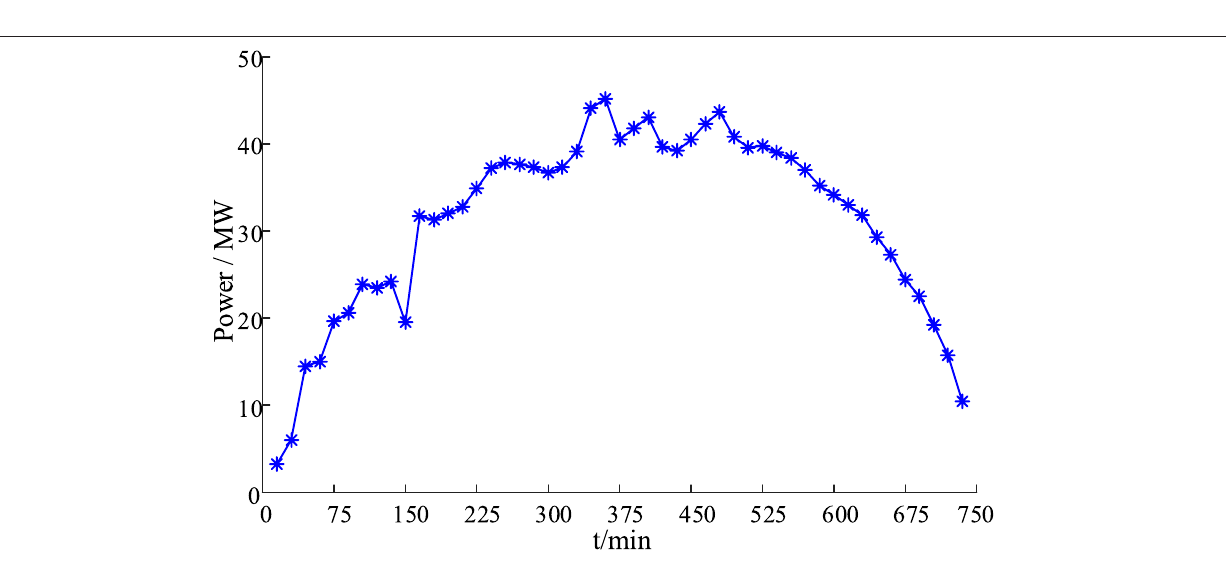
FIGURE 5 | Actual output of PV power